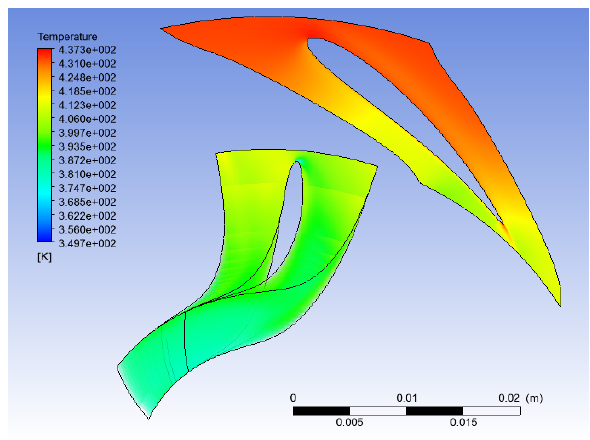
Figure 23. CFD study results: Temperature